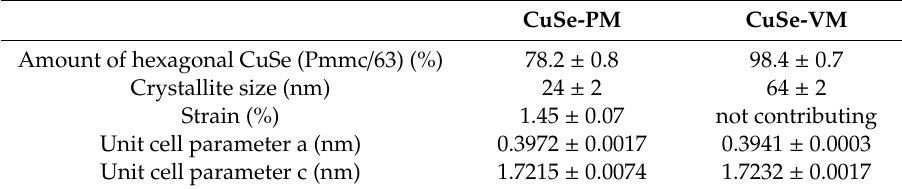
Figure 3. XRD patterns of Cu / Se mixtures milled in the vibratory mill for 5 and 10 min. Typical reflections are assigned to the CuSe phase. Table 1. Results of the Rietveld refinement of final CuSe products.